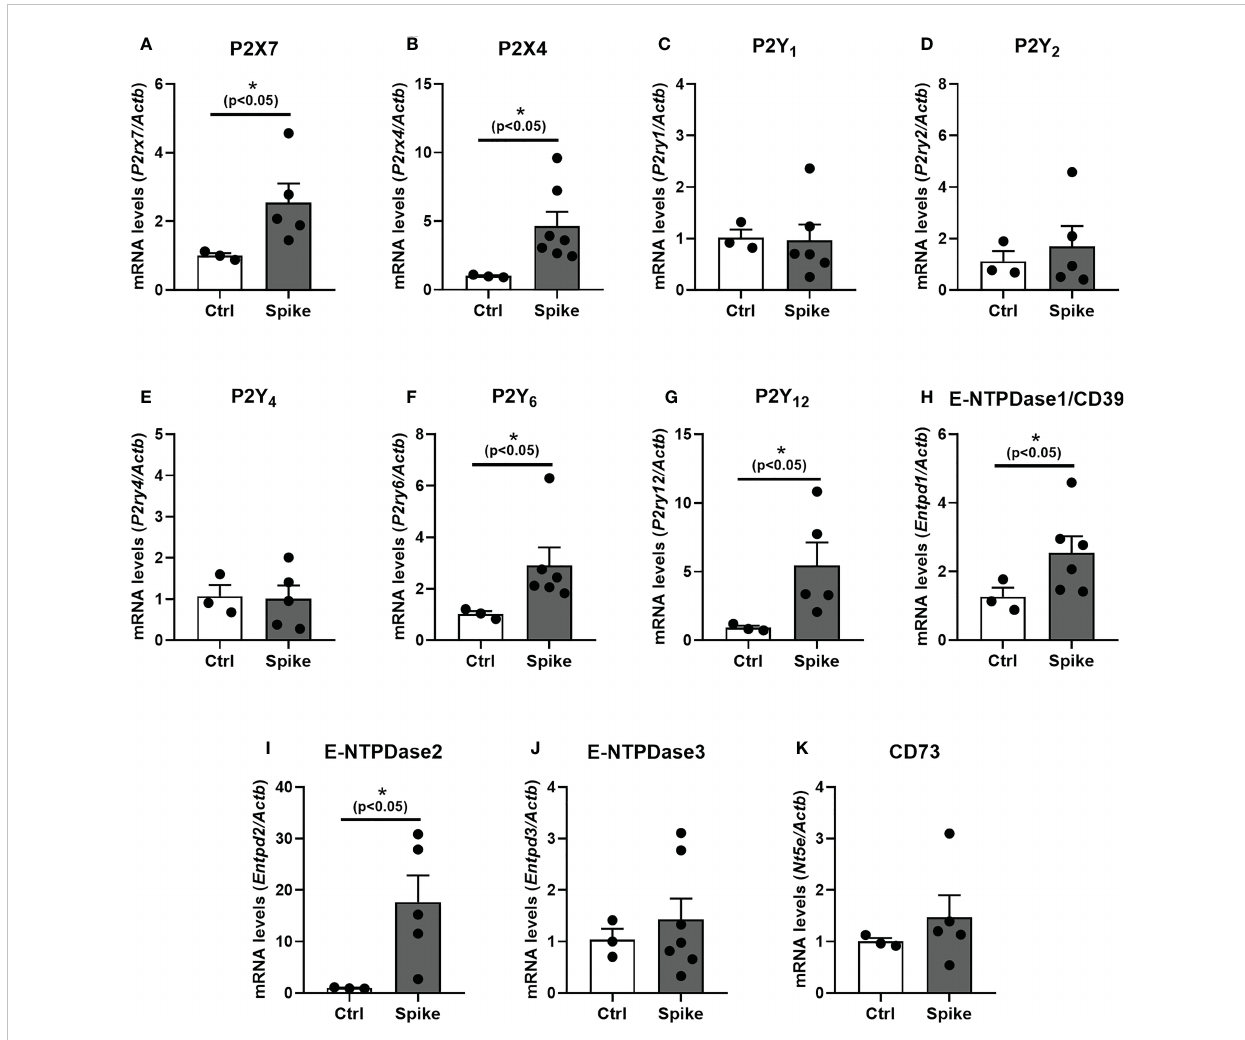
FIGURE 3 SARS − CoV − 2 spike protein increases purinergic signaling components transcript levels in mice hippocampus. The levels of transcripts for (A) P2X7, (B) P2X4, (C) P2Y 1 , (D) P2Y 2 , (E) P2Y 4 , (F) P2Y 6 , (G) P2Y 12 , (H) E-NTPDase1, (I) E-NTPDase2, (J) E-NTPDase3, and (K) CD73 in hippocampus of mice post-spike ICV injection were analyzed by RT-qPCR. Data are expressed as mean ± SEM. Statistically signi fi cant differences between the